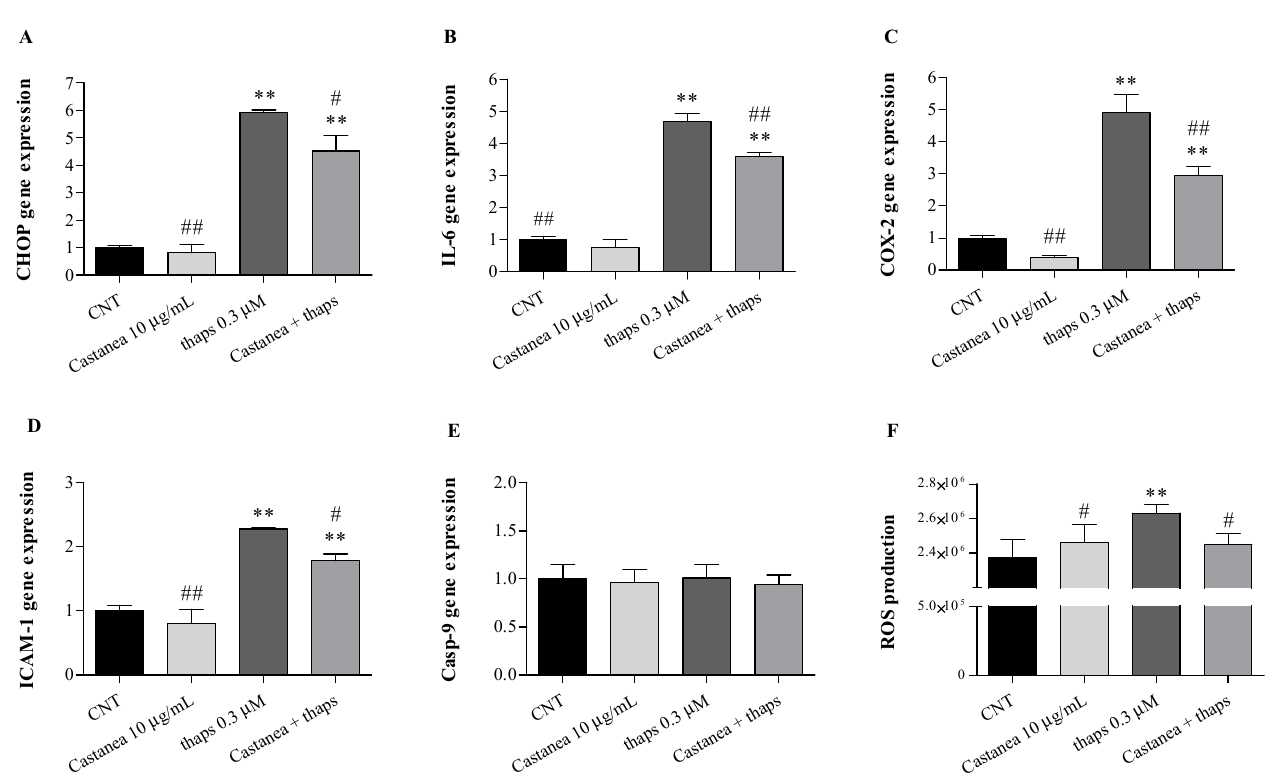
Figure 3. Effects of 1 h pre-treatment with 10 µg/mL Castanea bee pollen on HMEC-1 exposed 2 h to 0.3 µM thapsigargin (thaps): ( A ) CHOP, ( B ) IL-6, ( C ) COX-2, ( D ) ICAM-1, and ( E ) Casp-9 (Real-Time qPCR); ( F ) cellular ROS production (DCFH-DA assay). One-way ANOVA with Dunnett’s multiple comparison test: * significantly different from control (CNT): ** p < 0.01. # significantly different from thaps 0.3 µM: # p < 0.05; ## p < 0.01.